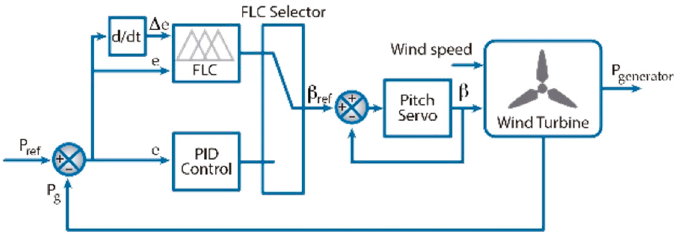
Figure 8. Different types of controllers where the control method is selected according to the needs of the system, the controller selection depends on a different controller [49].